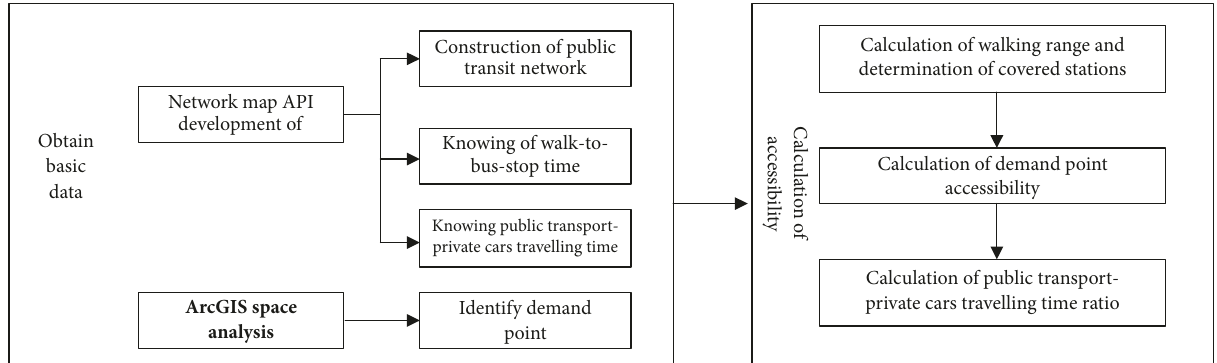
Figure 1: Technology